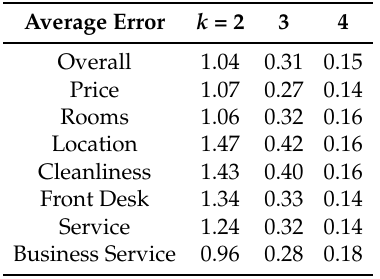
Table 11. Average flooring error for hotel ratings.